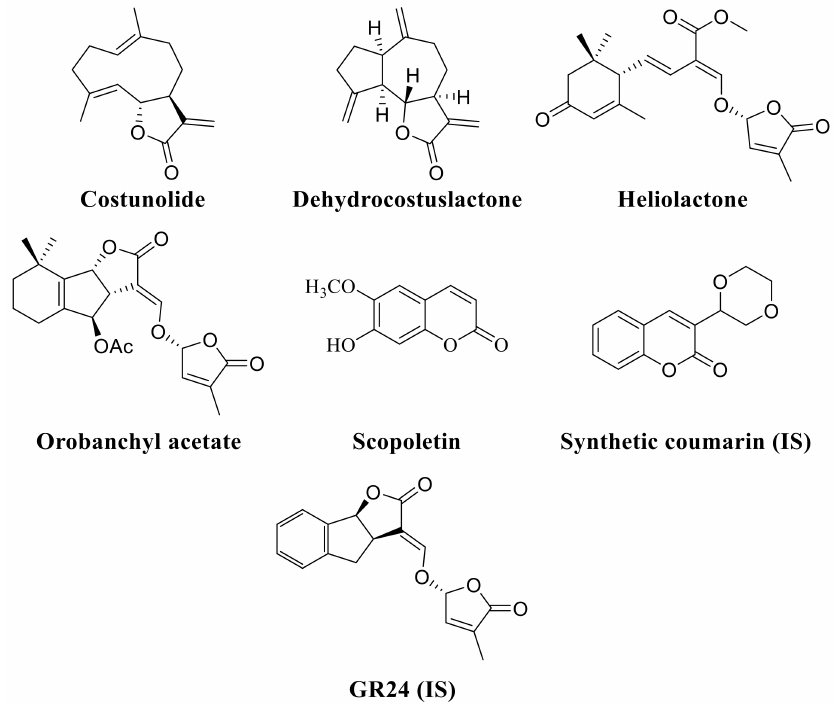
Figure 1. Structures of costunolide, dehydrocostuslactone, heliolactone, orobanchyl acetate, scopo- letin, the synthetic coumarin used as the internal standard (IS) and GR24 (synthetic SL used as internal